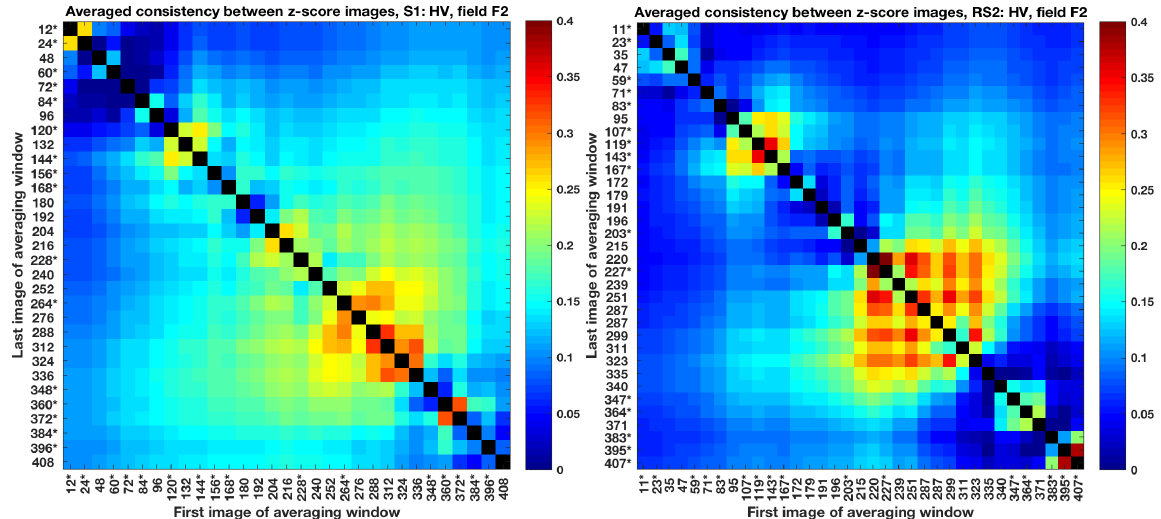
Figure 14. Consistencies for S1 HV ( left ) and RS2 HV ( right ) averaged over time windows based on the elements in Figure 13 with the first image on the horizontal axis and the last image on the vertical axis. Both axes present days from start of growth and asterisks indicate which acquisitions were rain-affected. Diagonal values were omitted and colored